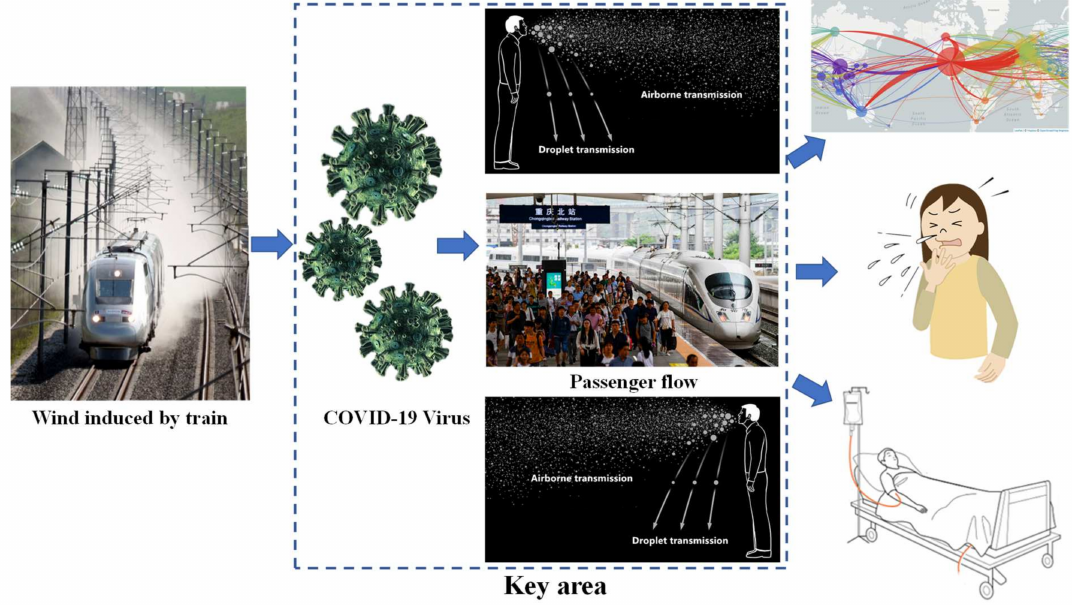
Figure 1. COVID-19 model of the airborne (wind-spread) transmission pathway near the